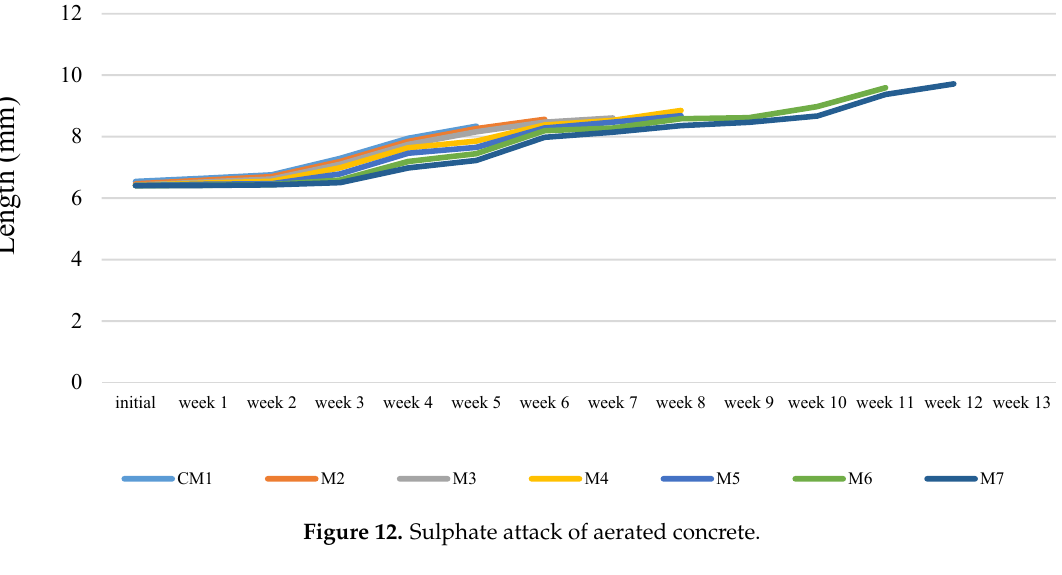
Figure 12. Sulphate attack of aerated